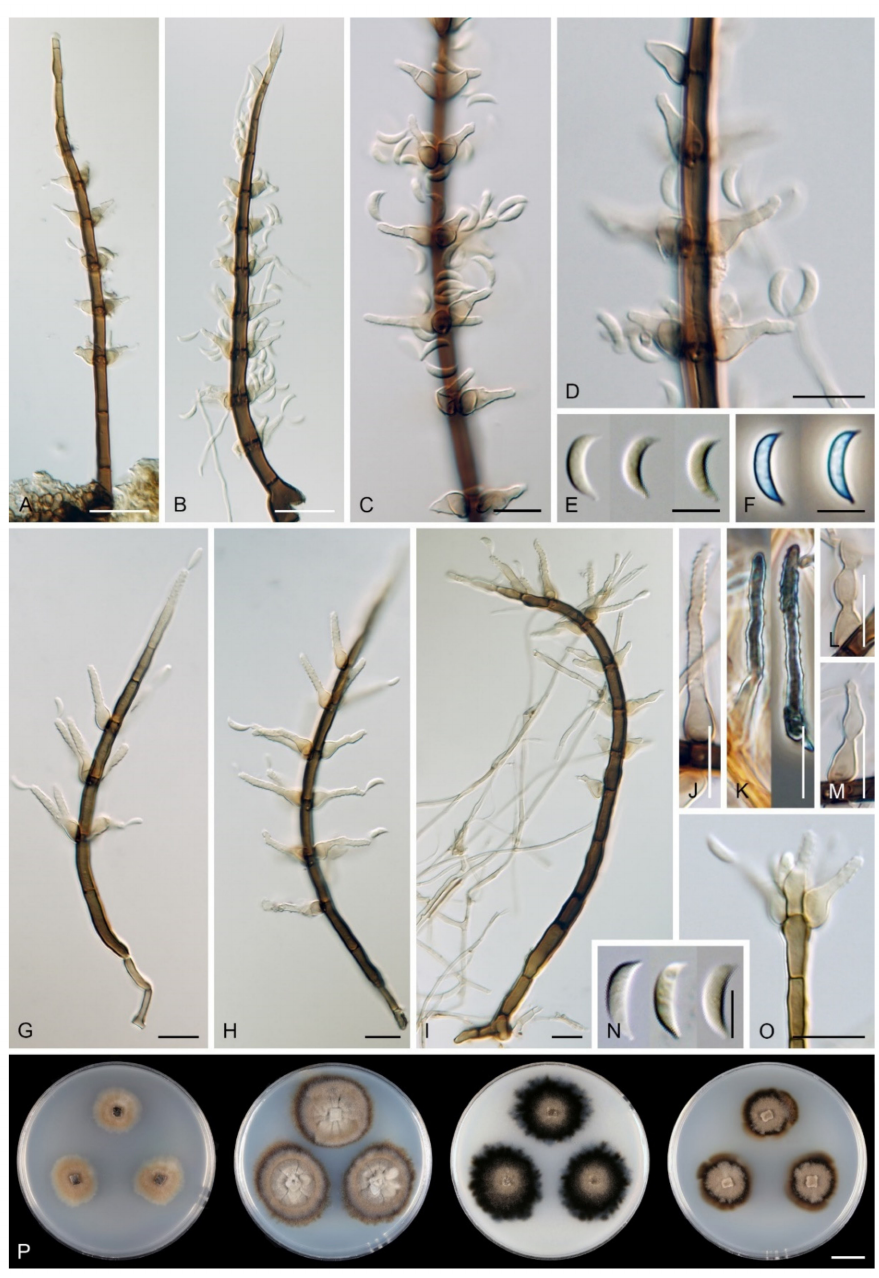
Figure 19. Brachiampulla verticillata . ( A – C , G – I ) Conidiophores. ( D , J – M ) Details of conidiogenous cells. ( E , F , N ) Conidia. ( O ) Apical part of the conidiophore. ( P ) Colonies on CMD, MLA, OA and PCA after 4 weeks (from left to right). Images: ( A – F , P ) on the natural substrate (ICMP 15993); ( G – O ) on PCA after 8 weeks (ICMP 15065 ex-paratype). Bars: ( A , B ) = 20 µ m; ( C – D , G – N ) = 10 µ m; ( E , F , O ) = 5 µ m; ( P ) = 1